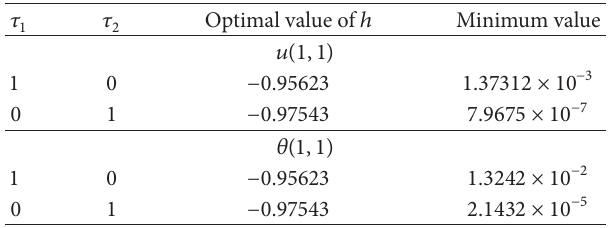
Table 1: The optimal values of ℎ at third-order approximate solutions of (14) when 𝑥 = 1.0, 𝑡 = 1.0 , for 𝛿 = 1, 𝜎 1 = 0.2, 𝜎 2 = 0.1, Ω = 0.1, and 𝜔 = 0.02 .